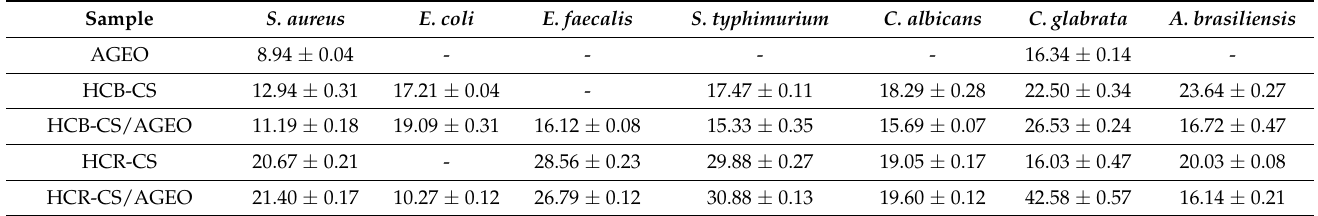
Table 4. Enlisting the results obtained from diffusion disk assay: represented by the diameters of the inhibition zones (measured in